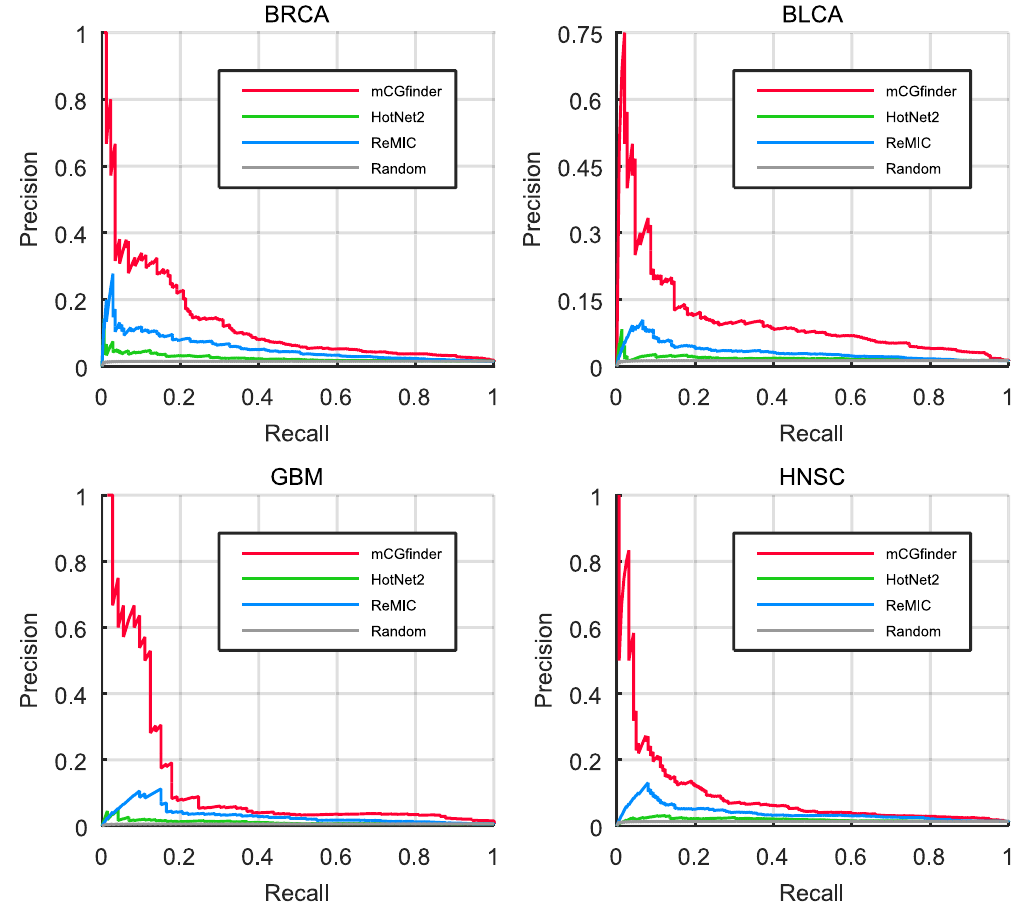
Figure 4. Precision-recall curves for the three methods on BRCA (north-west panel), BLCA (north-east panel), GBM (south-west panel) and HNSC (south-east panel) data, where red, green, blue and gray lines represent the curves of mCGfinder, HotNet2, ReMIC and random selection respectively. For each curve, the points indicate the precisions and recalls at different ranks in the prediction results. The precision is computed as the fraction of the top ranked genes that are known cancer genes, and the recall is computed as the fraction of known cancer genes in the top ranked genes.